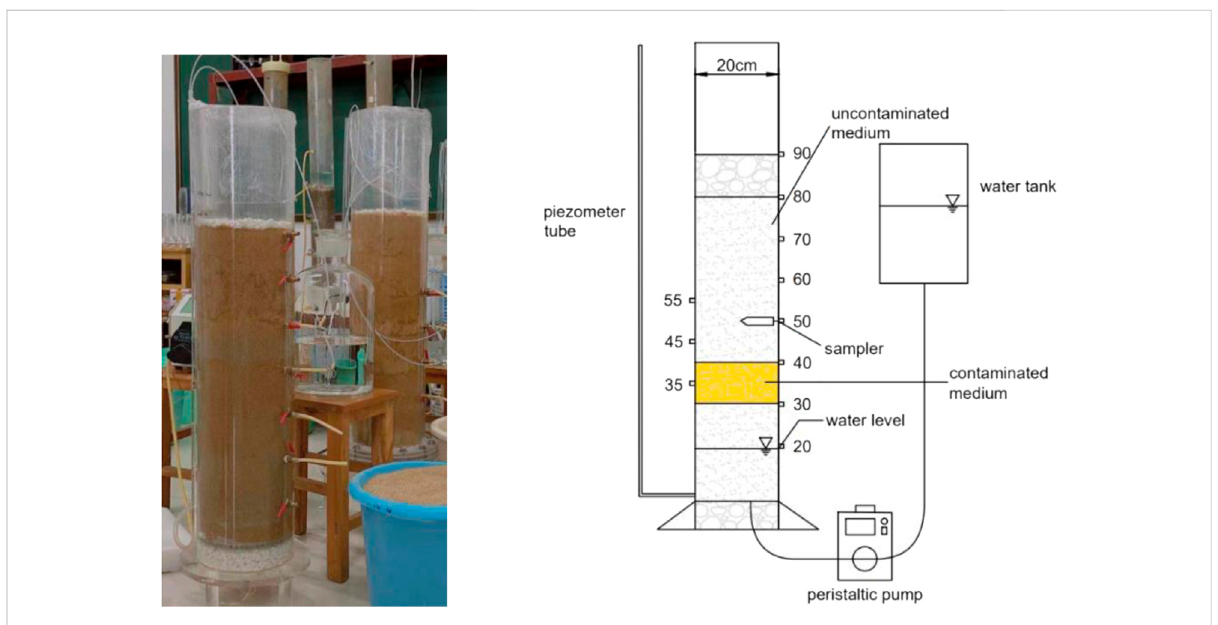
FIGURE 1 Schematic diagram of the experimental